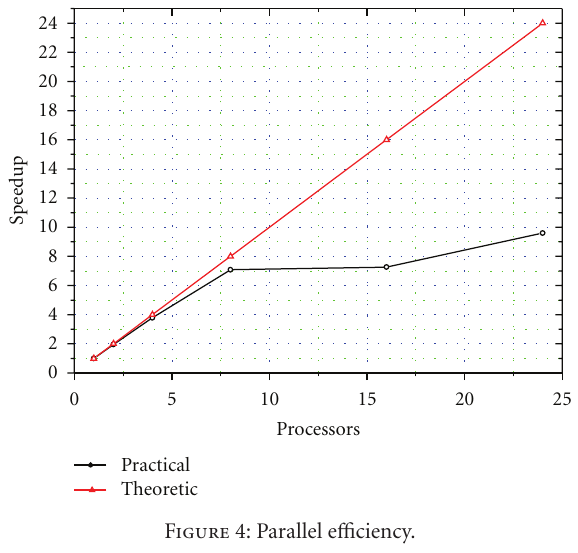
Figure 4: Parallel e ffi